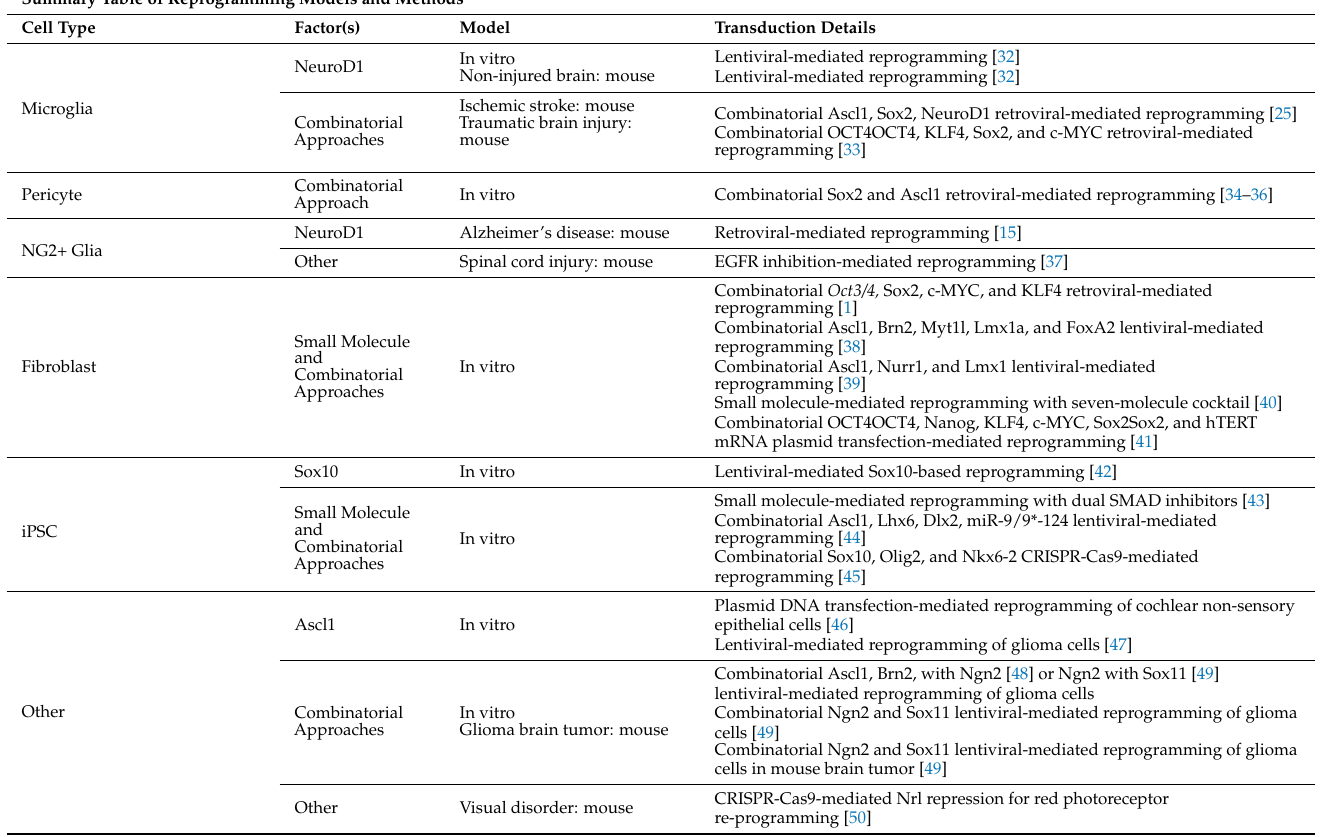
Summary Table of Reprogramming Models and